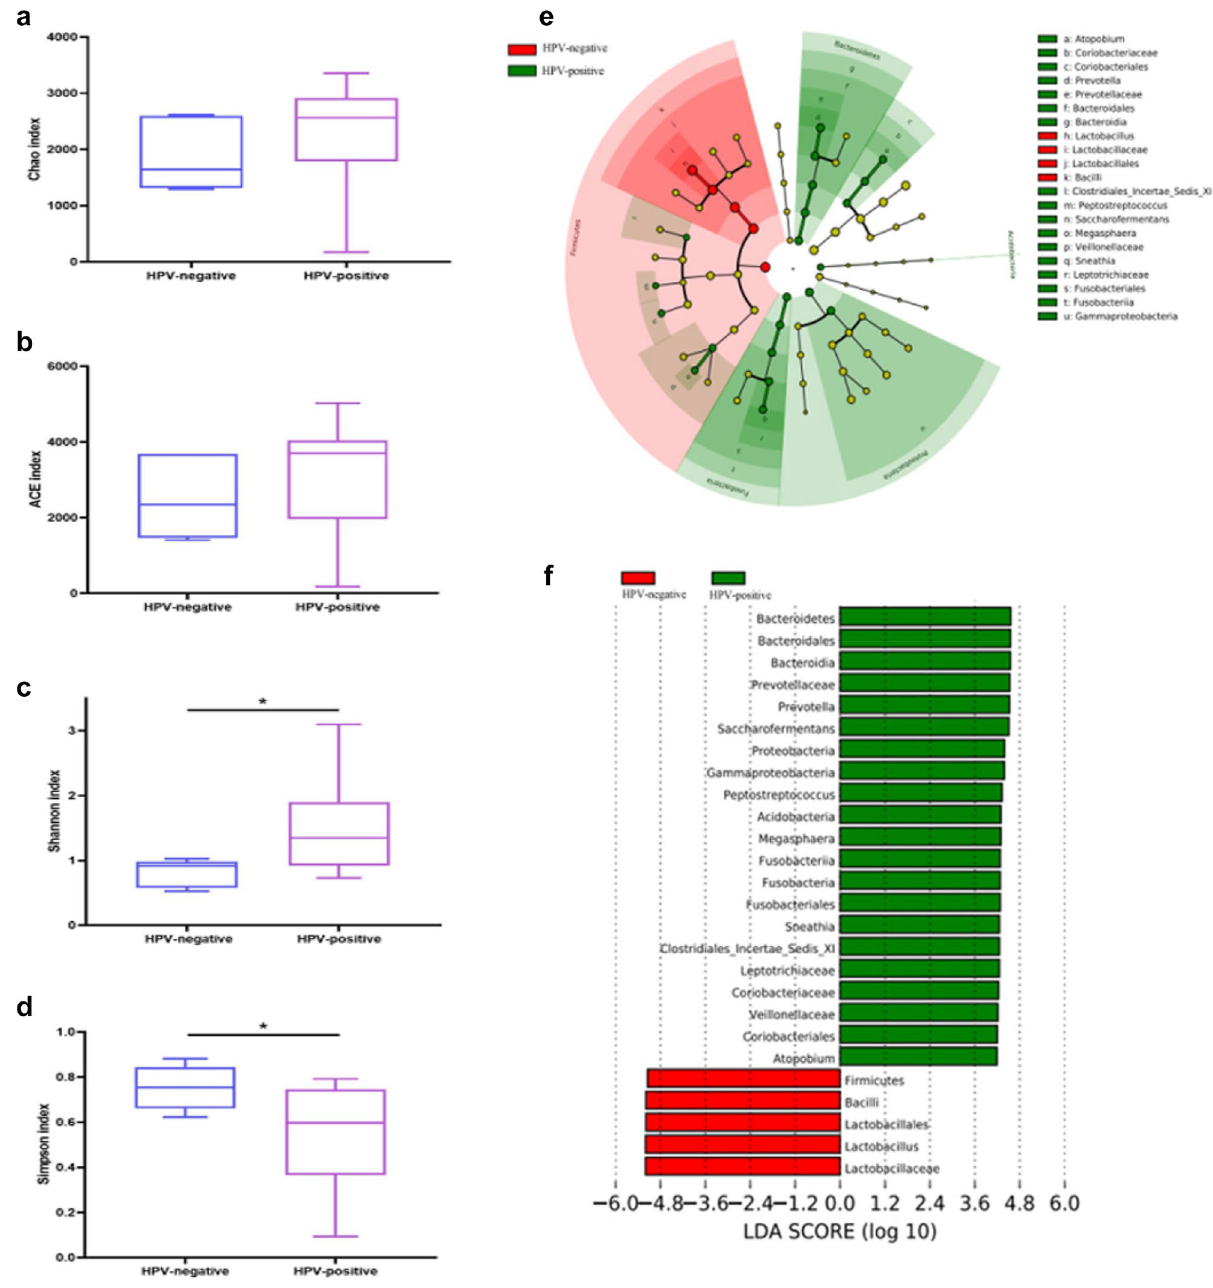
indicate the groups of microorganisms that play an important role in the corresponding group of the color. Yellow nodes indicate groups of microorganisms that have not played an important role. The species names represented by the English letters in the picture are shown in the legend on the right. ( f ) LDA scores distribution histogram shows the two groups’ dominant microbial distribution: the X-axis is the LDA score obtained after LDA analysis, and the Y-axis is the group of microorganisms with significant